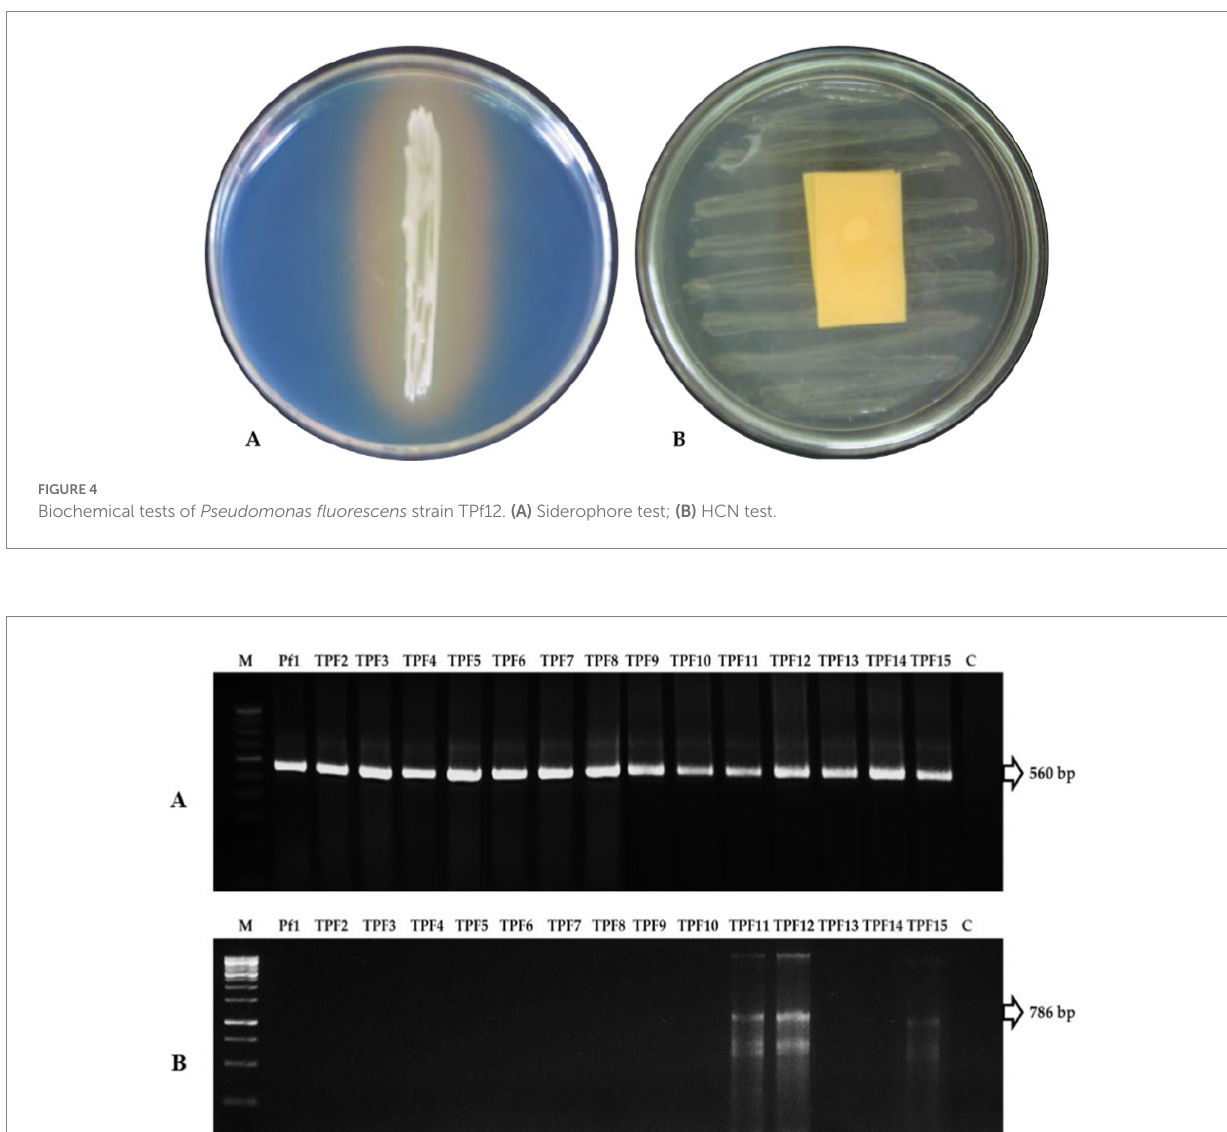
TPf12 treatments exhibited no symptoms, whereas FOL pathogen- inoculated plants displayed wilt